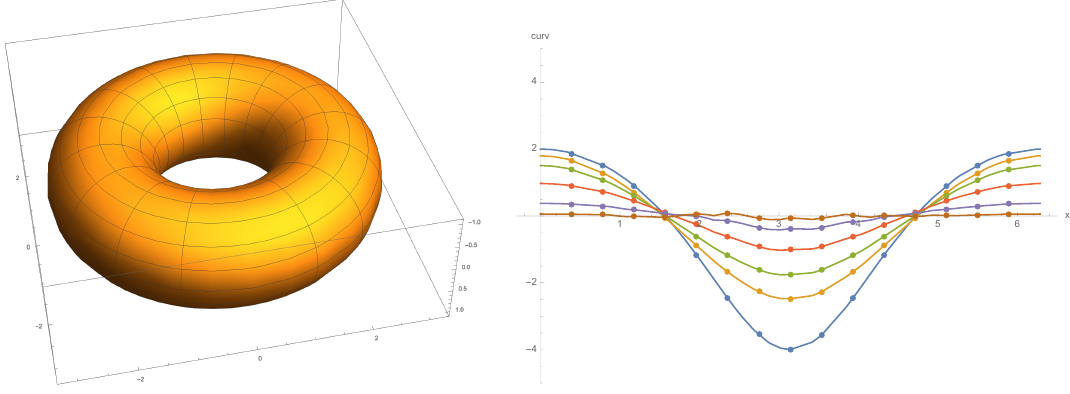
Figure 3 . The scalar curvature of the real torus on the left is plotted as a function of the angular coordinate of the torus. By solving the Ricci flow equations we see a gradual shift to a metric of approximately zero scalar